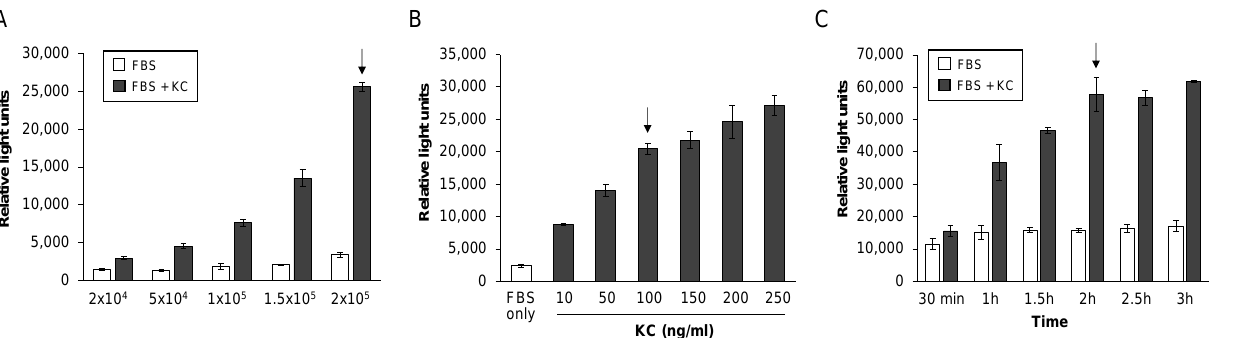
Figure 2. Chemotaxis responses by bone-marrow-derived neutrophils to keratinocyte chemokine (KC). Depicted are responses of neutrophils to different conditions that stimulate chemotaxis in response to either FBS alone or FBS plus added KC, each quantified using CellTiter-Glo to detect cells that have migrated into the bottom chambers of transwell plates. Shown are chemotaxis responses to ( A ) 100 ng/mL of KC with different numbers of cells added to the chambers after 2 h of incubation, ( B ) increasing concentrations of KC with 2 × 10 5 cells total and 2 h of incubation or ( C ) different times of incubation (hours, h) after adding 2 × 10 5 cells and 100 ng/mL of KC to the chambers. The arrow in each graph indicates optimal responses for conditions used in subsequent assays. All data shown are averages ± standard deviations (SD) from triplicate tests per condition, and represent one of at least three separate replicate assays including independent preparations of neutrophils from bone marrow.